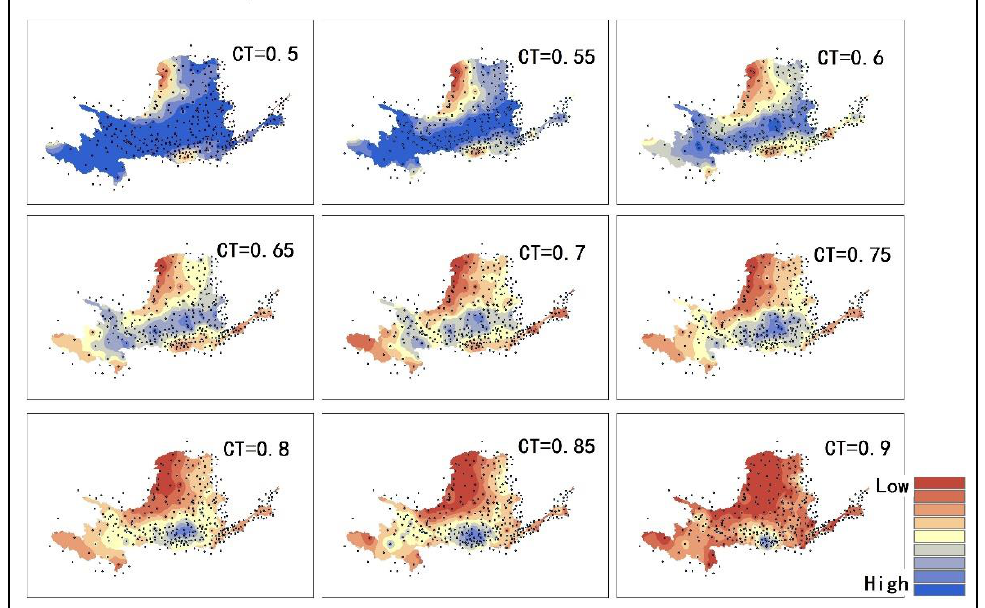
Figure 5. The spatial distribution of vertex degree (P-network).